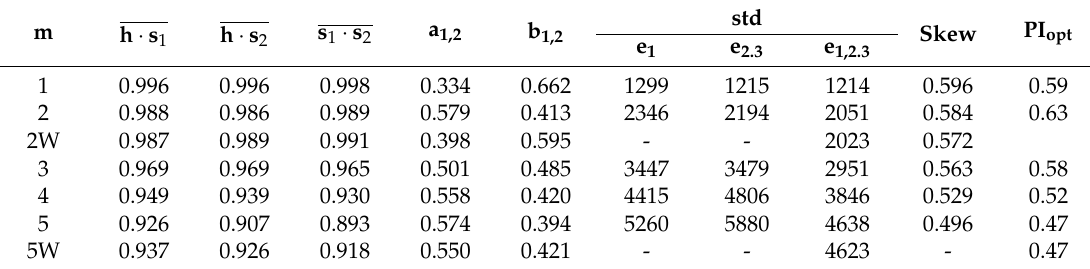
Table 4. Results from combinations of model 2 and model l. Columns 2, 3, and 4 show parameters (correlation coefficients) for all error equations, column 5 and 6 are parameters for Equations (7) and (8). All std in m³/s.